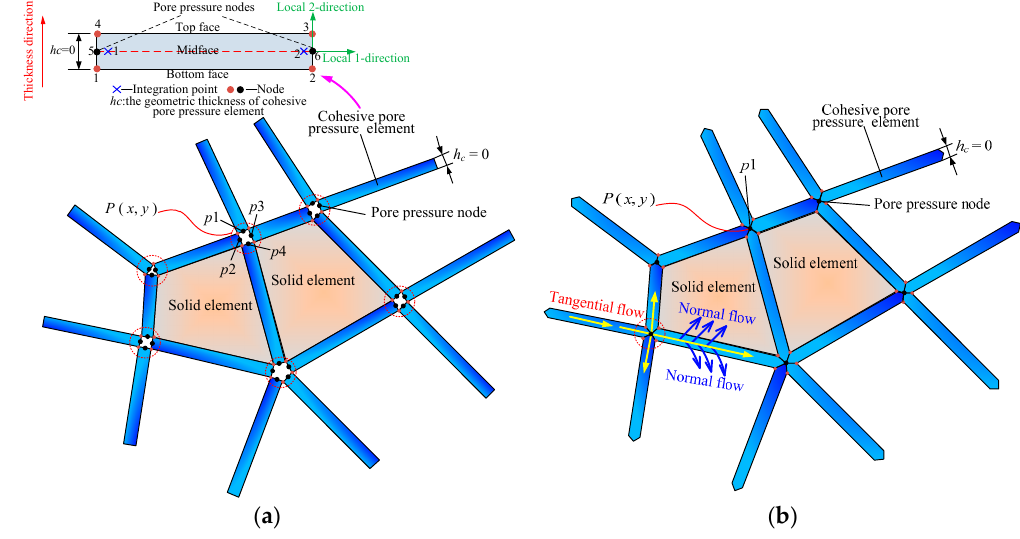
Figure 2. ( a ) Schematic of the CPPE and the mesh structure by embedding discrete CPPEs; ( b ) the mesh structure after merging the pore pressure nodes at the same coordinates and the concept of fracturing liquid flow in fractures. Note that the CPPEs are zero-thick, and the pore pressure nodes p 1, p 2, p 3, p 4 have the same coordinates P ( x , y ). The fracturing liquid flow has two components: the tangential flow from one cohesive element to the next cohesive element, and the normal flow from cohesive elements to solid elements.